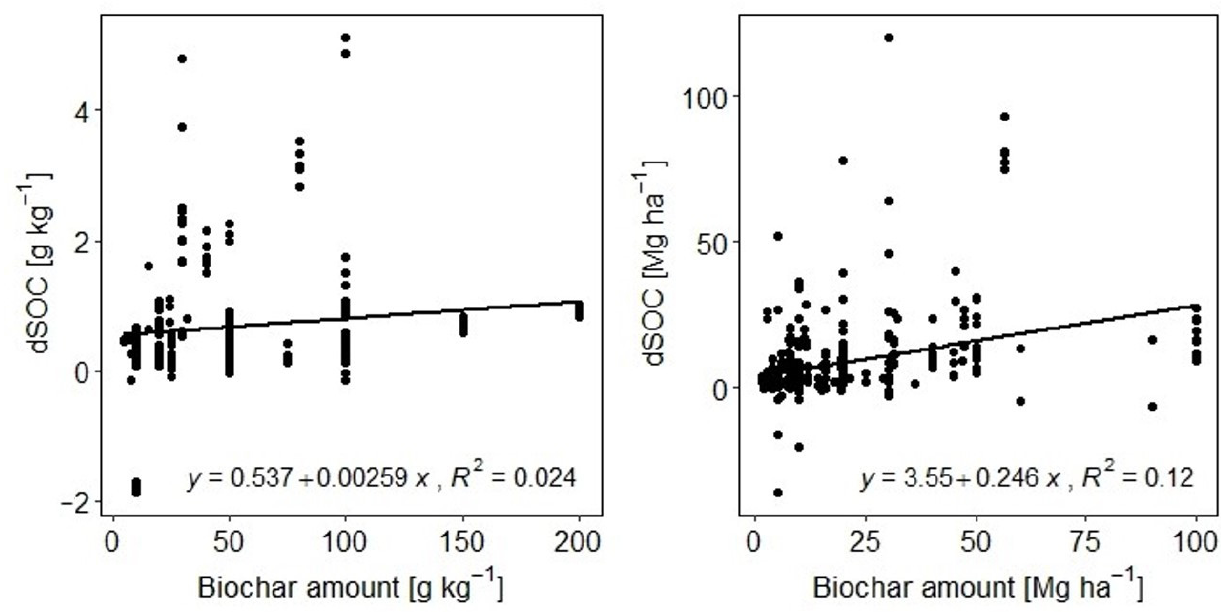
Figure 7. Relationship between the biochar amount and absolute SOC difference (dSOC) and, in laboratory and greenhouse treatments ( left ) and field treatments ( right ). In laboratory and greenhouse treatments both variables are given as g kg − 1 , and field treatments both variables are given as Mg ha − 1 . R 2 represents the coefficient of determination.